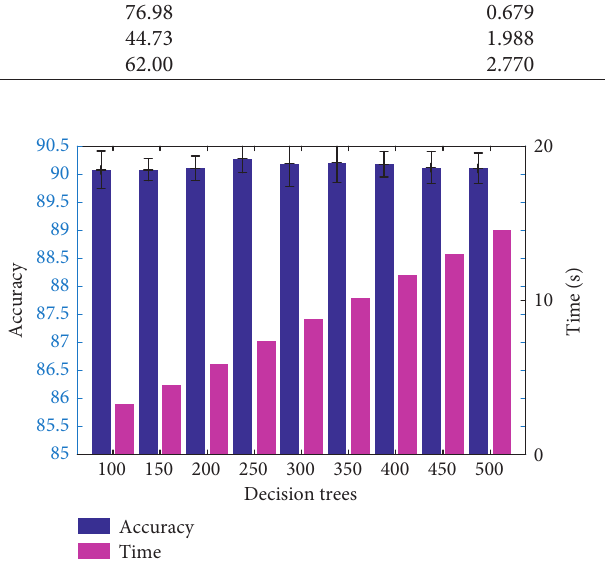
Figure 5: The experiment results for the wind turbine gearbox based on the SL